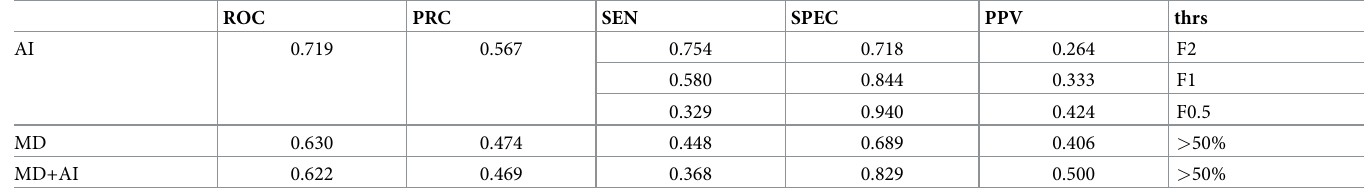
Table 3. Results of the reader study which shows the performance of physicians predicting infections within the next 90 days—without (MD) and with (MD+AI) decision support, in comparison to the automatic risk prediction (AI). Evaluation is carried out using ROC (Area under Receiver Operator Curve) and PRC (Area under Precision-Recall Curve), as well as SEN (sensitivity; recall), SPEC (specificity; true negative rate), and PPV (positive predictive value; precision) defined by different thresholds (thrs). The threshold defines the cutoff value to map from regression to binary classification. ROC PRC SEN SPEC PPV thrs AI 0.719 0.567